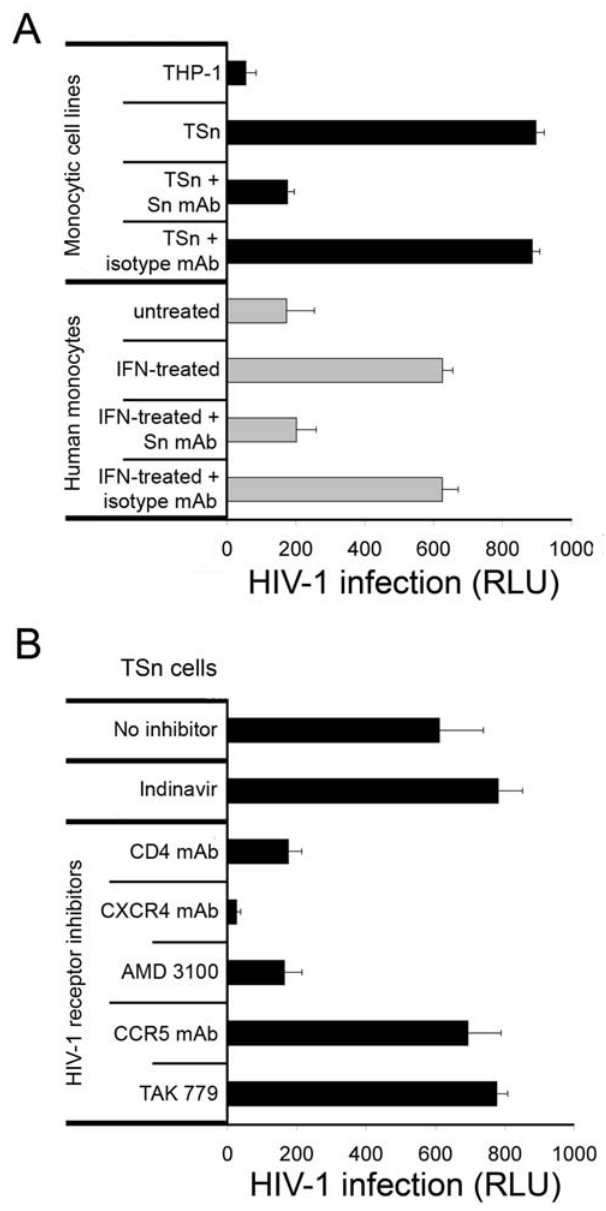
Figure 5. Sn-dependent trans infection of reporter cells TZM-bl. (A) Sn-expressing cells, TSn and IFN- a -induced monocytes, bind HIV-1 and infect TZM-bl cells in trans . Cells were incubated with HIV-1 NL4-3 for 1 h, washed and then cocultured with TZM-bl cells for 48 h. HIV-1 infection of TZM-bl was defined by luciferase expression and quantified as relative light units (RLU). Cells pretreated with Sn mAb 7D2 showed significantly reduced capacity to facilitate trans infection of TZM-bl cells while mAb IgG1 isotype control had no effect. (B) HIV-1 receptor inhibitors block trans infection. Receptor and coreceptor requirements for trans infection of TZM-bl cells were tested by incubating TZM-bl cells with receptor inhibitors including mAbs to CD4, CXCR4 or CCR5, and small molecules AMD3100 or TAK779 prior to adding TSn with bound HIV-1 NL4-3 . The CD4, CXCR4, CCR5, AMD3100 and TAK779 receptor inhibitors were tested individually with TZM-bl and did not induce luciferase expression (data not shown). As a control, productive infection of TSn cells was prevented by addition of indinavir (100 m M). Data presented are the average of three separate experiments. Error bars represent SD.